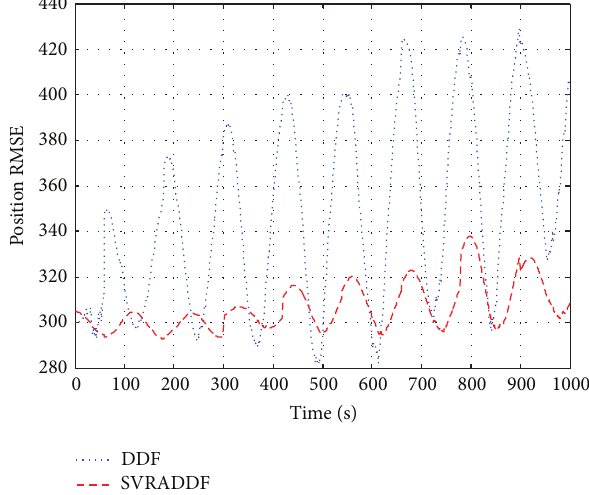
Figure 6: RMSE in position for DDF and